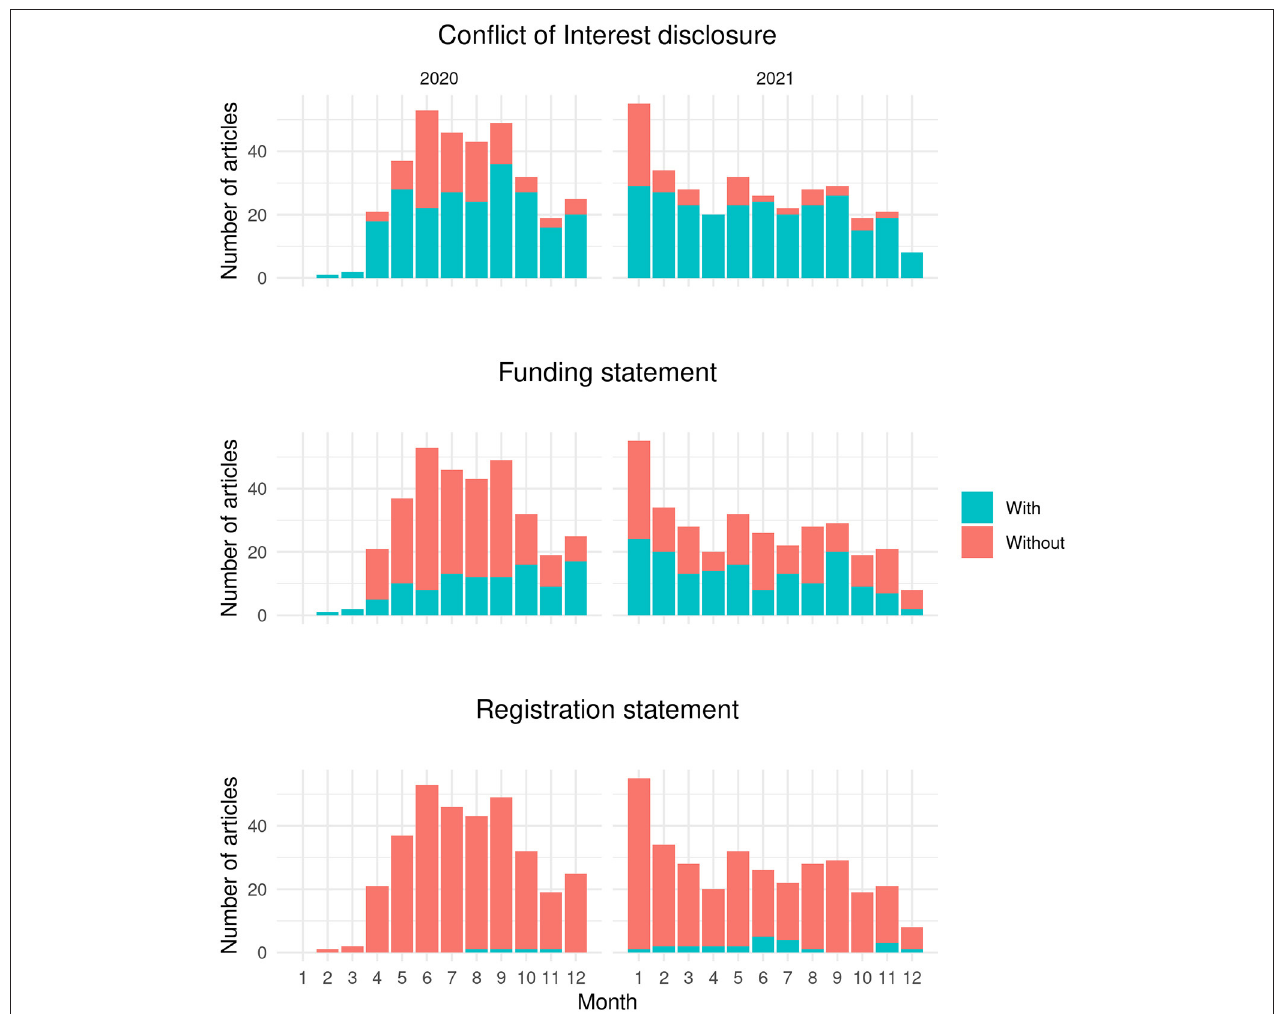
FIGURE 1 | The monthly trend for three transparency indicators, namely conflict of interest (COI) disclosure, funding statement, and registration for 2020 and